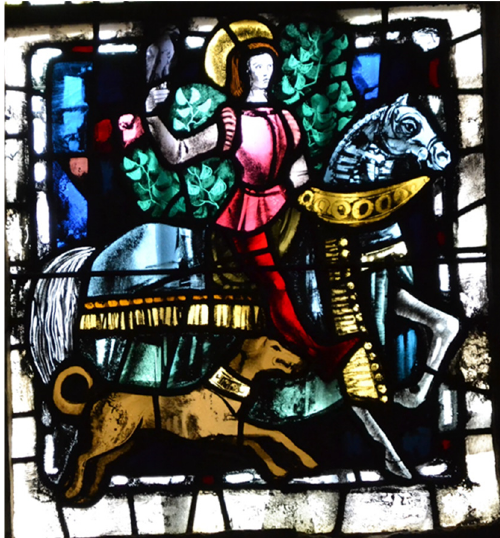
Figure 11. Saint-Lô, Church of Notre-Dame, Saint-Thomas chapel, Life of Saint Thomas window, 1968, detail, Chancellor Thomas hunting. © author.